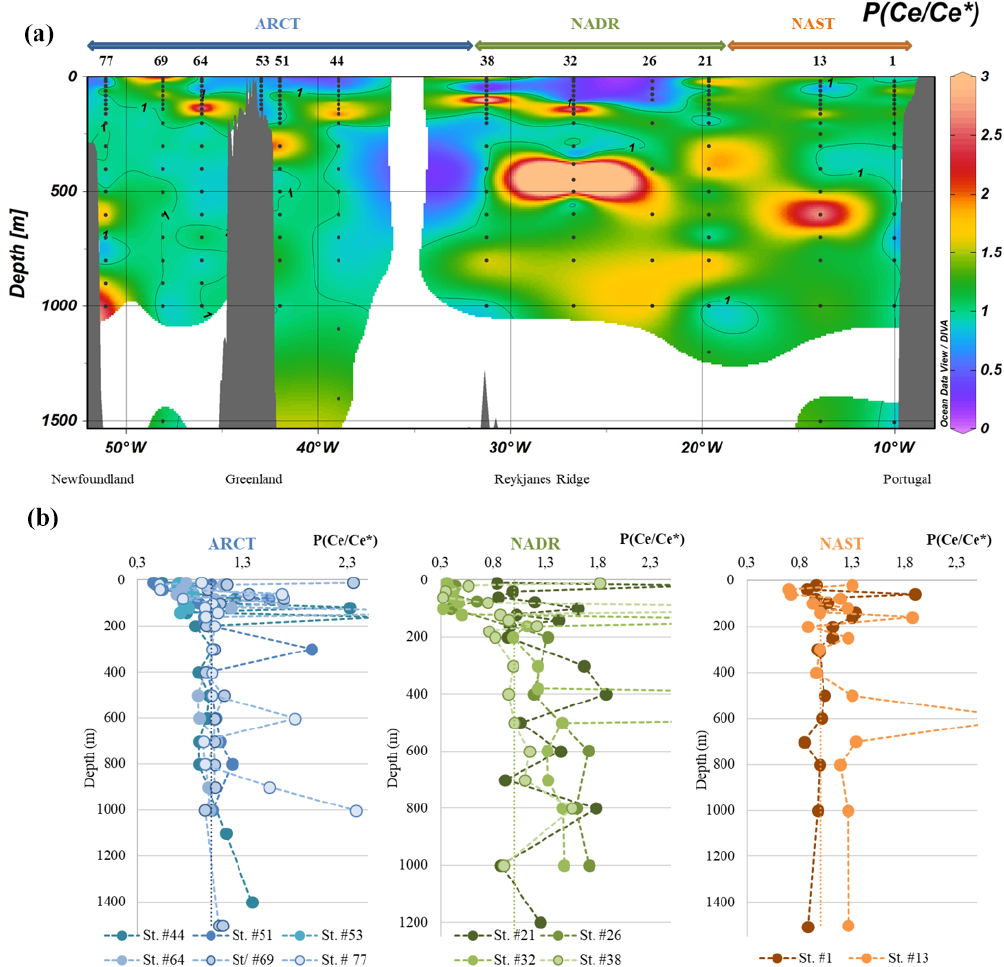
Figure 7. (a) Particulate Ce anomaly (Ce / Ce ∗ ) along the GEOVIDE section, interpolated with the DIVA gridding function of Ocean Data View and (b) Ce / Ce ∗ profiles grouped by biogeochemical provinces (ARCT, NADR, NAST). Panel (a) presents the first 200m and panel (b) all the data. Values above 2.5 are not represented. The dashed black vertical line in each panel represents the absence of anomaly